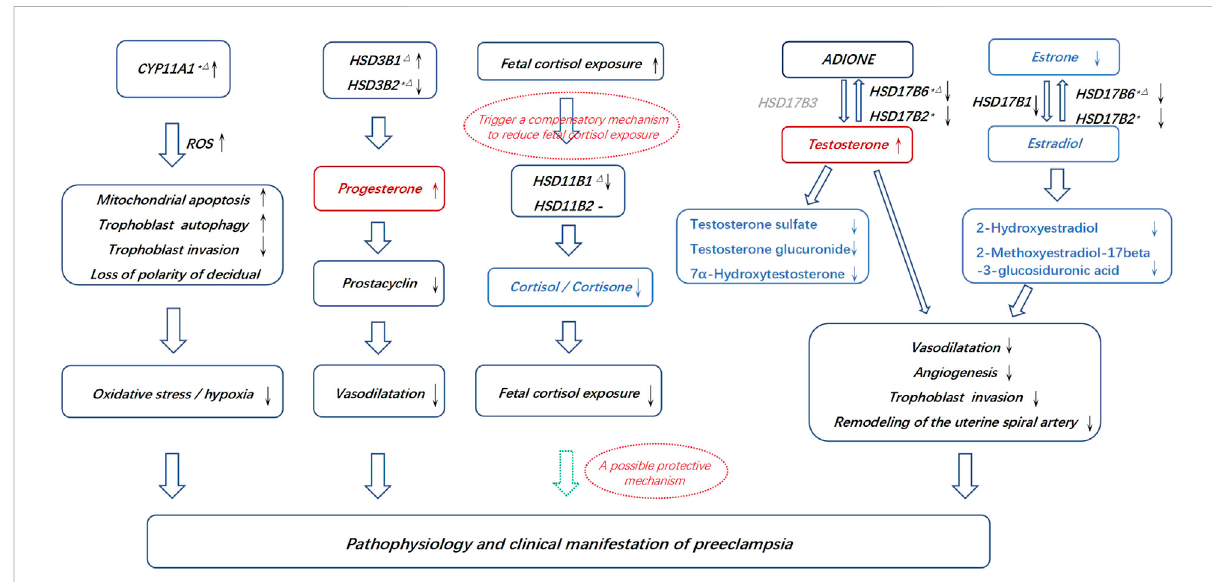
FIGURE 5 Possible connections between the pathogenesis of PE and the aberrant placental synthesis and metabolism of steroid hormones. * Differential genes in the discovery and RNA microarray validation. △ Differential genes in the discovery and qPCR validation. The dotted hollow arrow in green represents a potential protective effect. The metabolites in red represents an accumulation, and the metabolites in blue represents aberrantly affected biosynthesis. The gene in grey represents that it is lack in